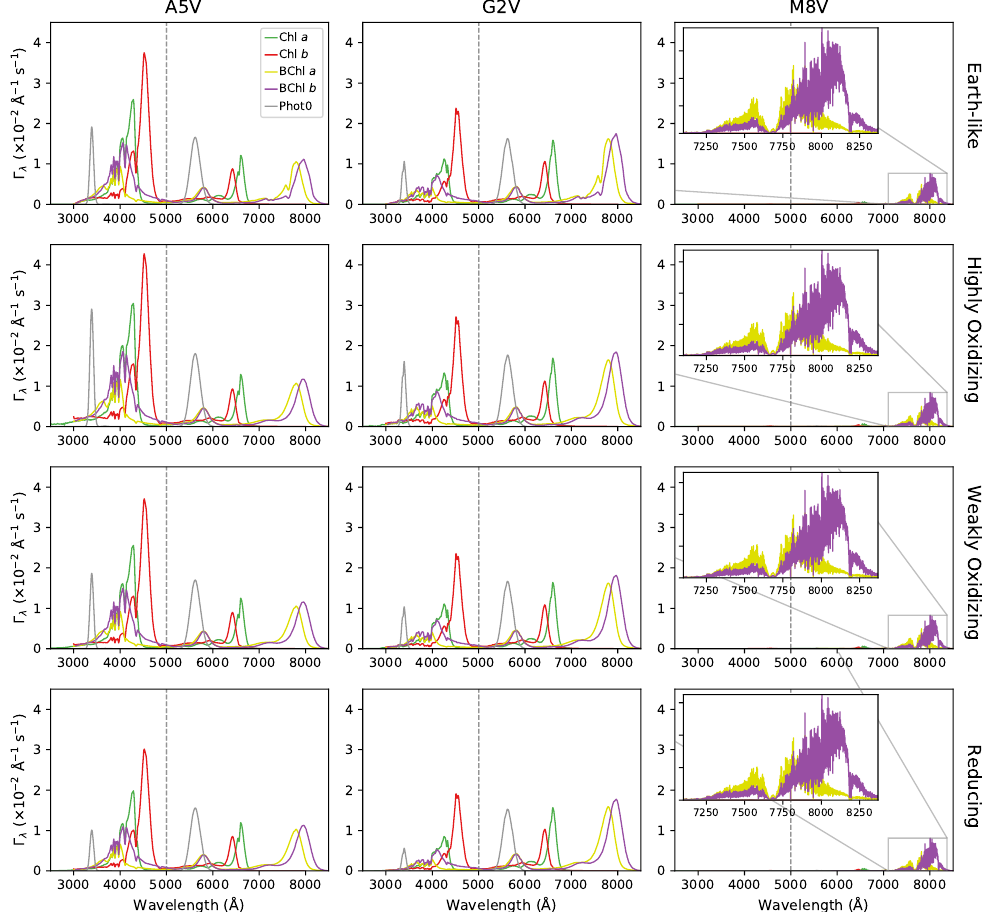
Figure 2. Spectral absorption rates for five photopigments (Chl a , Chl b , BChl a , BChl b , and Phot0) on Earth-like exoplanets with four different atmospheres (Earth-like, highly oxidizing, weakly oxidizing, and reducing, in their respective rows) in the HZm around stars of three different spectral types (A5V, G2V, and M8V, in columns). The vertical dashed lines mark the cut-off wavelength separating the Q and B bands at 5000Å. All panels follow the same color code (cf. upper left panel legend). For the sake of visualization, we smoothed the M8V star spectra with a 25-point running average and displayed zoom-ins of the region of